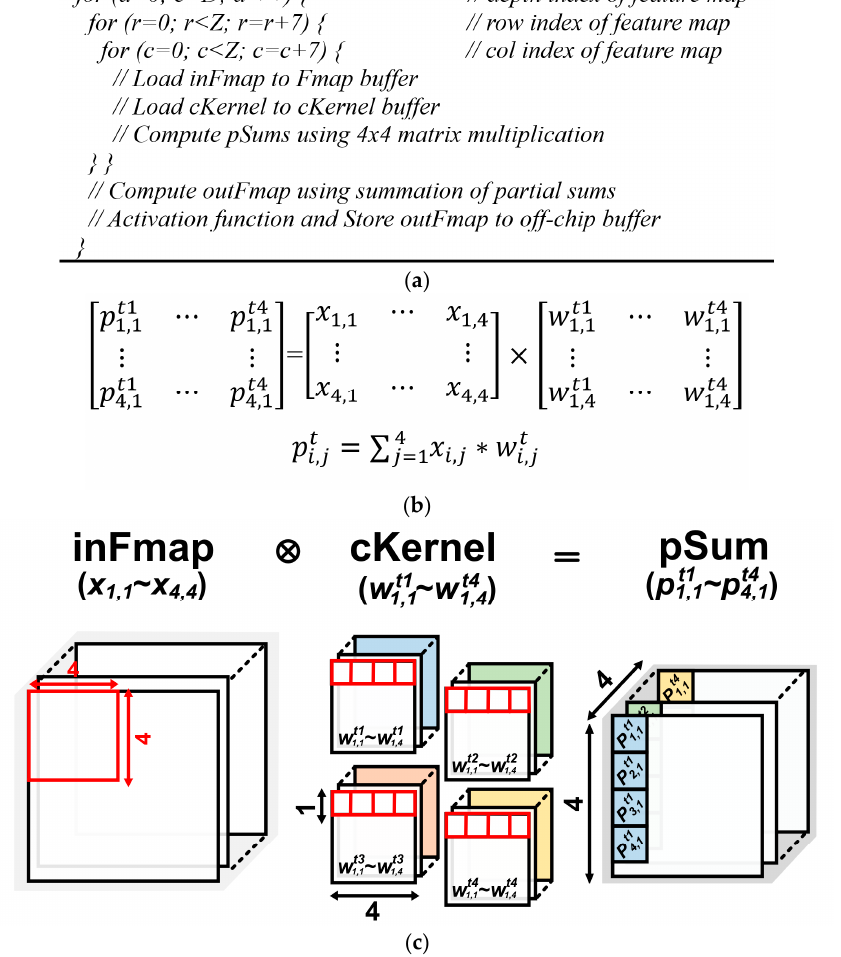
Figure 7. Convolution operation inside CENNA architecture: ( a ) pseudo code of convolution layer inside CENNA; ( b ) equation of convolution using matrix multiplication; ( c ) Illustration of matrix